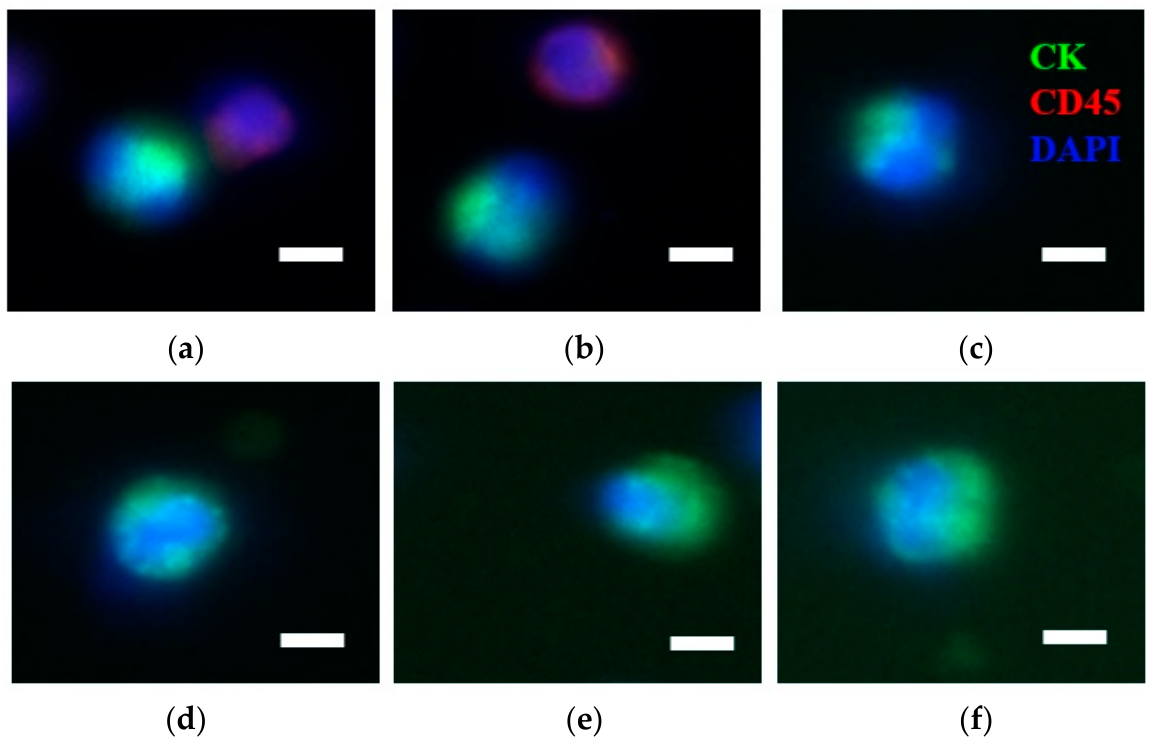
Figure 1. Circulating urothelial cancer cells are present in blood samples from patients. ( a – f ), Immunofluorescence staining of representative cells obtained from IsoFlux. Cancer cells fulfilled criteria for CTCs, including: nucleated (blue), CK-positive (green), and CD45-negative cells (non-red). Scale bar, 10 µm.